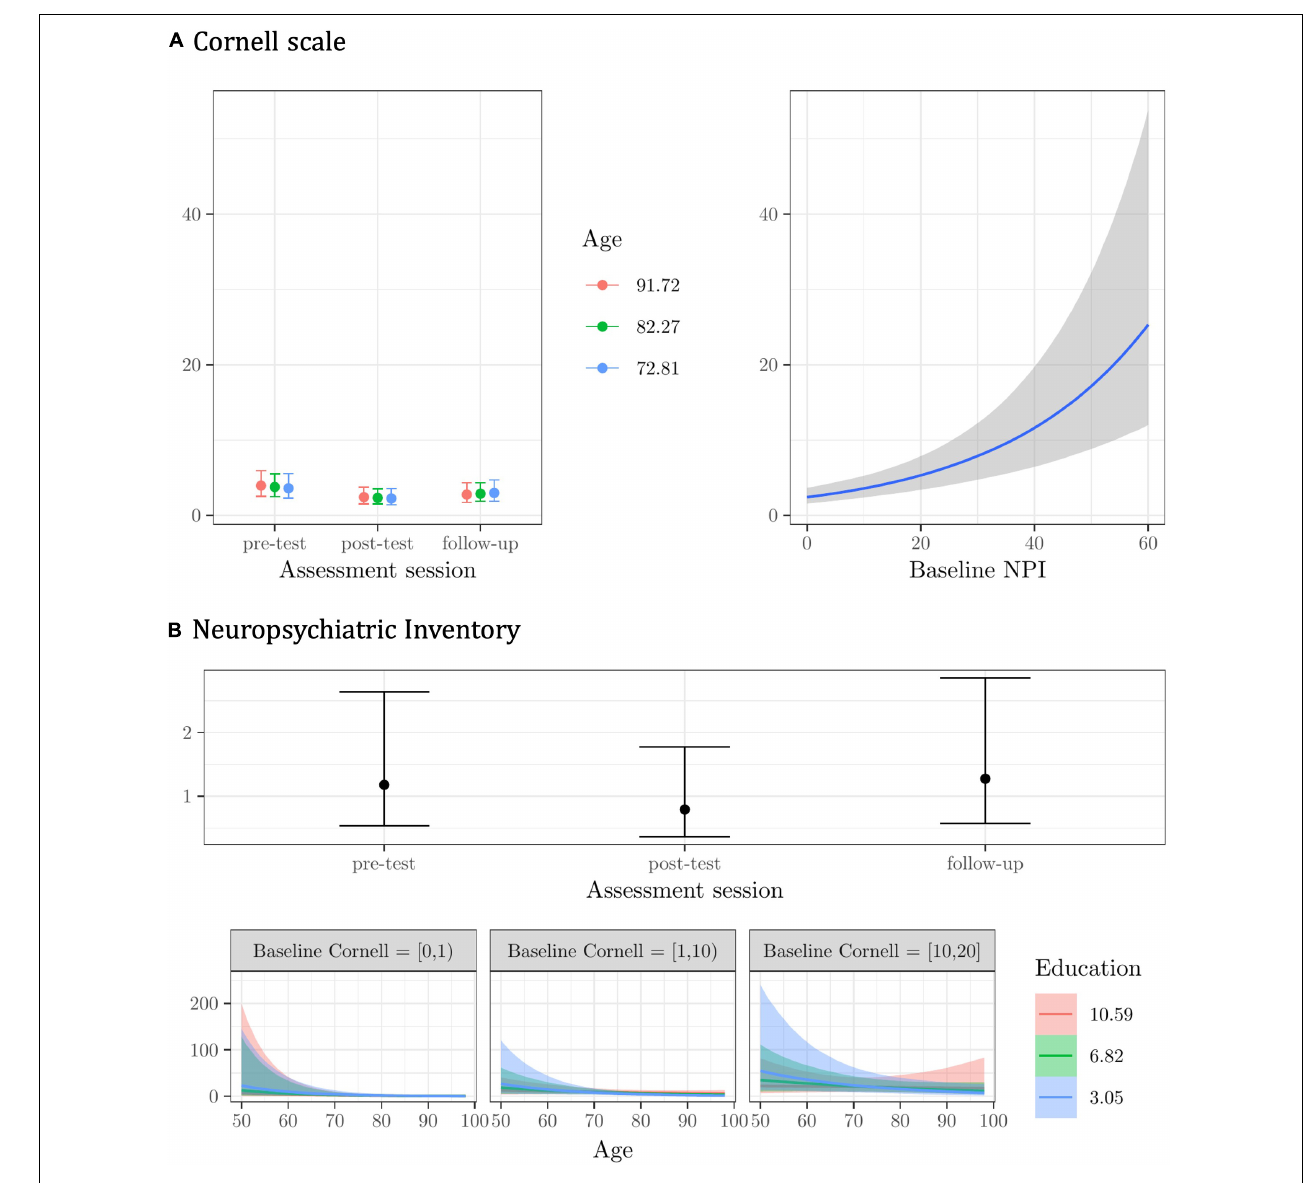
FIGURE 2 | Plots of the best model’s predictions for the secondary outcome measures. (A) Cornell scale -depression symptoms-. (B) Neuropsychiatric Inventory (NPI) -behavioral/neuropsychiatric symptoms-. For each measure, the plots represent the conditional effects of the predictors on the dependent